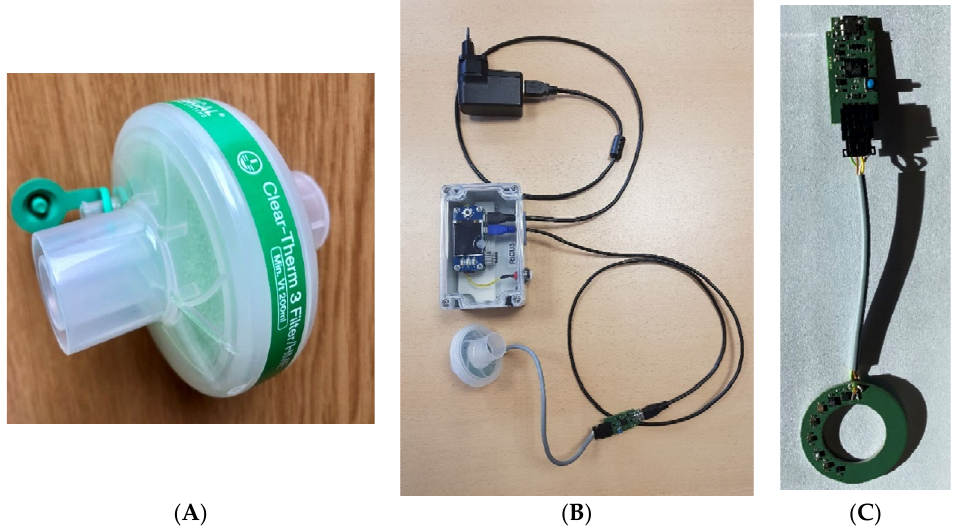
Figure 1. ( A ) Clear-Guard MIDI breathing filter with Luer port; ( B ) sensor device adapted for use in the mechanical lung ventilation machine; the device embedded in the Clear-Guard MIDI breathing filter, a sensor signal registration device (Raspberry Pi), and a power adapter; ( C ) sensor board connected to a micro-USB